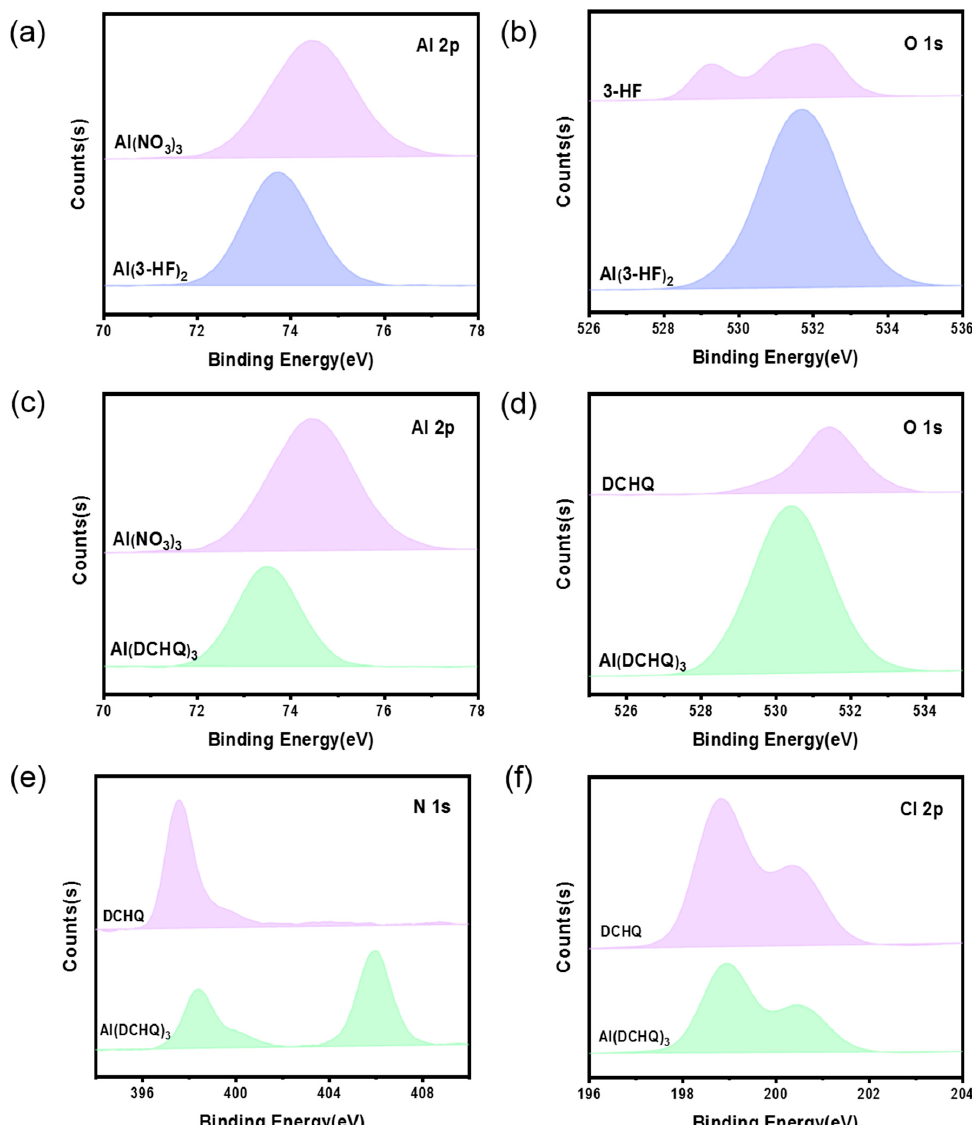
Al 2p, O 1s, N 1s, and Cl 2p for Al(NO 3 ) 3 ligands and complexes are compared in Figure 3. There was a certain difference in the binding energy of Al 2p between Al(3-HF) 2 and the metal salt. Compared to Al(NO 3 ) 3 , the binding energy of Al 2p in Al(3-HF) 2 decreased by 1.1 eV (i.e., 74.8 vs. 73.7 eV), as shown in Figure 3a. Similarly, the binding energy of Al 2p in Al(DCHQ) 3 shifted by 1.4 eV (i.e., 74.8 vs. 73.4 eV), as shown in Figure 3c. As for the difference in the binding energy of O 1s between the ligand 3-HF (532.15 eV) and Al(3-HF) 2 (531.7 eV), the shift of binding energy was 0.45 eV before and after complex formation (Figure 3c), while the shift between DCHQ (530.45 eV) and Al(DCHQ) 3 (531.45 eV) was 1 eV (Figure 3d). In contrast, the N 1s binding energy increased (i.e., 397.6 vs. 405.9 eV) in Al(DCHQ) 3 (Figure 3e) compared to Al(NO 3 ) 3 , which is caused by the Al–N coordination probably due to N-bond distortion [25]. The binding energy of Cl 2p had no shift in DCHQ and Al(DCHQ) 3 (Figure 3f), and the binding energy of C 1s had no shift in either 3-HF and Al(3-HF) 2 or DCHQ and Al(DCHQ) 3 , as shown in Figure S3.